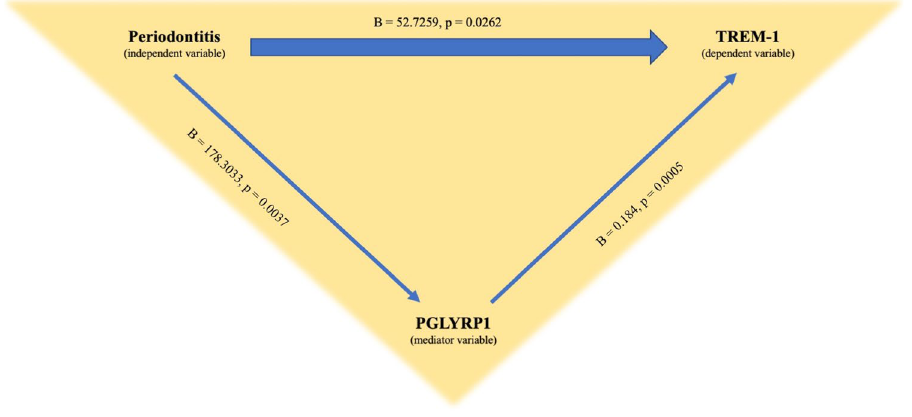
Figure 3. Scheme of the mediation analysis that illustrates the direct effect of “periodontitis” as independent variable on the dependent variable “TREM-1”, as well as the indirect effect of “PGLYRP1” as the mediator